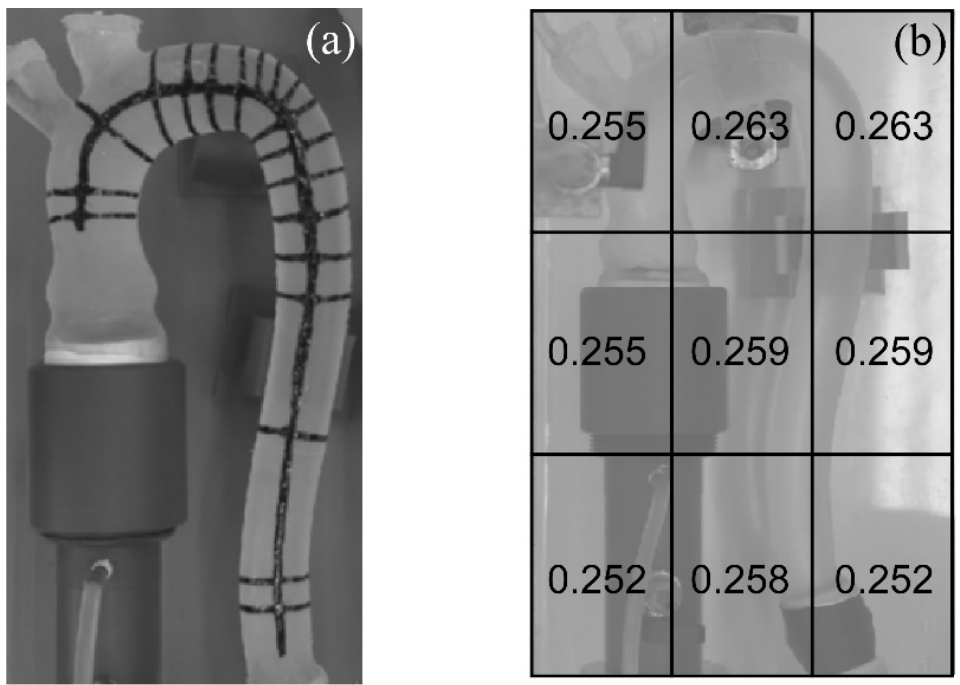
Figure 3. A frame of the silicone aortic phantom tested in the pulse duplicator, ( a ) with fish-bone- shaped configuration marked with black nail polish, and ( b ) with the pixel sizes estimated in six regions of the phantom. The values reported are in mm.